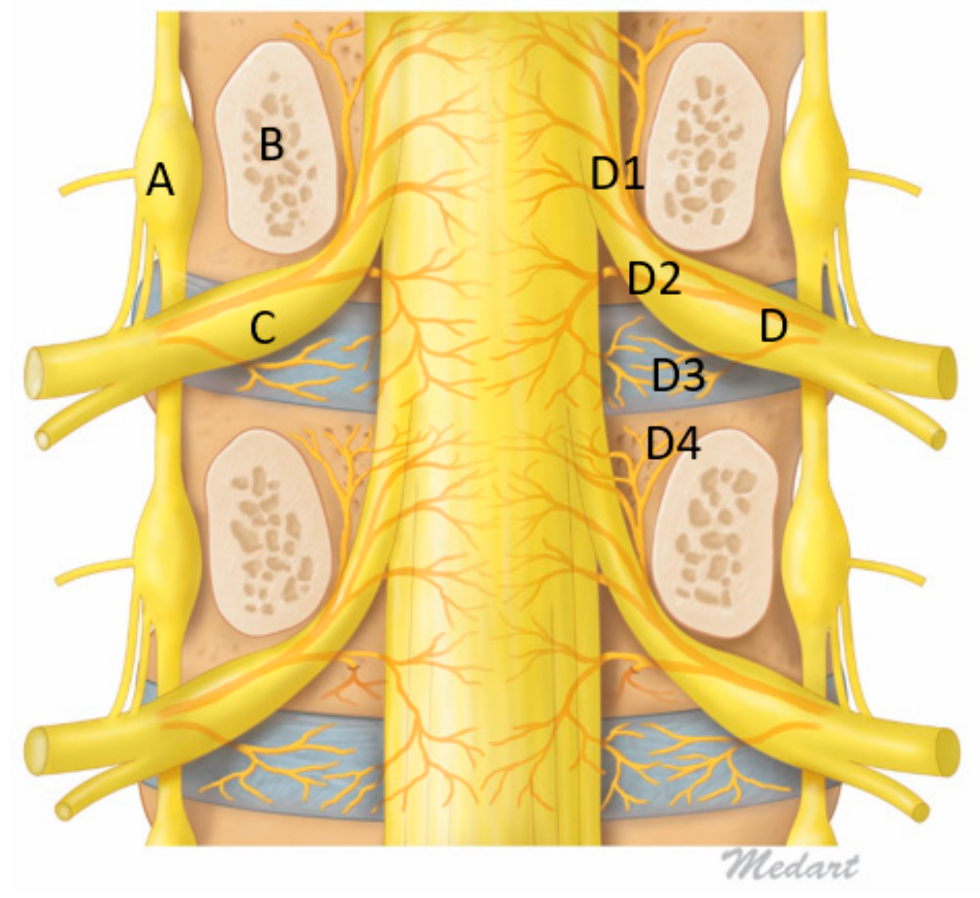
Figure 2. Figure of Coronal Mid Pedicle Cut of Lumbar Spine. A: Sympathetic ganglion, B: Pedicle, C: Dorsal Root Ganglion, D: Sinuvertebral Nerve giving rise to branches D1: Ascending branch which goes intraosseous and give rise to Basivertebral Nerve near the pedicle D4, D2: Descending Branch supplying adjacent to Posterior longitudinal ligament and disc, D3: Direct branches to intervertebral disc.